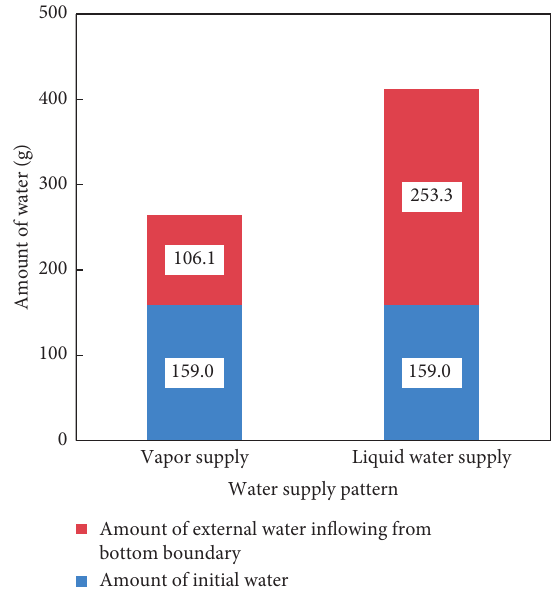
Figure 6: Amount of water in samples of different water supply method.